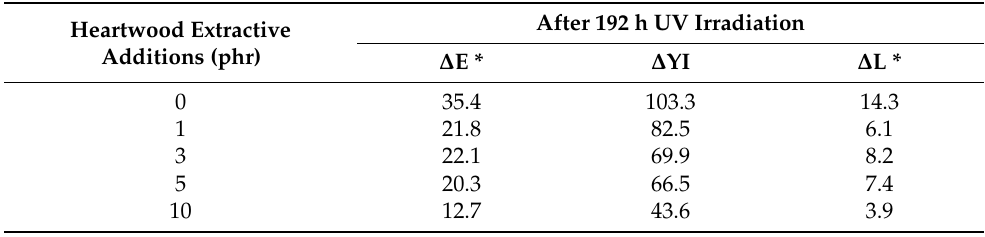
Table 3. Lightfastness of ROL films with various A. confusa heartwood extractive additions after 192 h UV